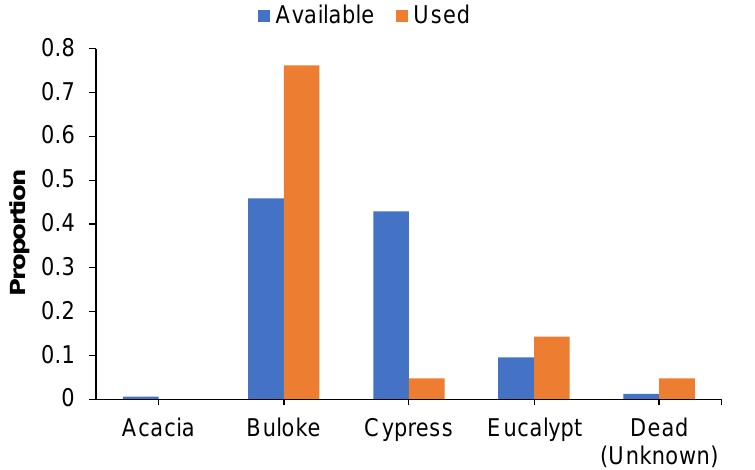
Figure 2. Column graph illustrating the proportion of roost (used) and locally available trees (>10 cm dbhob) represented by five broad species/groups in the AWC site, Central Pilliga. The use of living and dead trees for roosting differed significantly from local availa- bility ( χ 2 = 30.508, p < 0.001; Figure 3). Roost trees were generally dead (62% of all roost trees), with the use of dead trees significantly greater than availability in the local land- scape (270 stems > 10 cm dbhob per ha). Conversely, living trees (38% of all roost trees) were used less than expected based on availability in the local landscape (838 stems > 10 cm dbhob per ha). The use of dead trees for roosting by males (72% of roost trees) was greater than females (54%). Figure 3. Column graph illustrating the proportion of roost (used) and locally available trees (>10 cm dbhob) represented by living and dead trees in the AWC site, Central Pilliga. Most characteristics of roost trees differed significantly from locally available trees, with the exception of the senescence score (Figure 4a – e). The diameter of trees used for roosting was relatively small (~23 cm dbhob) but was significantly larger than locally available (~18 cm dbhob) trees irrespective of whether they were living ( W = 107, p = 0.044, n = 16) or dead ( W = 269, p = 0.017, n = 26). Similarly, roost trees were taller (8 – 12 m) than